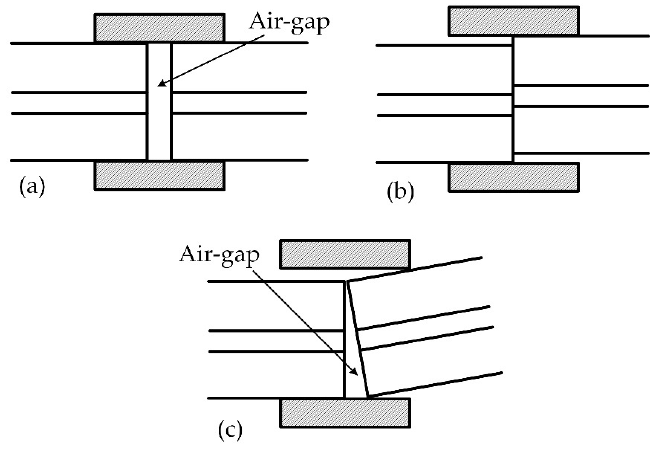
Figure 11. Offset between two optical fibers: ( a ) transverse offset or end-gap, ( b ) longitudinal offset or concentricity and ( c ) angular offset or